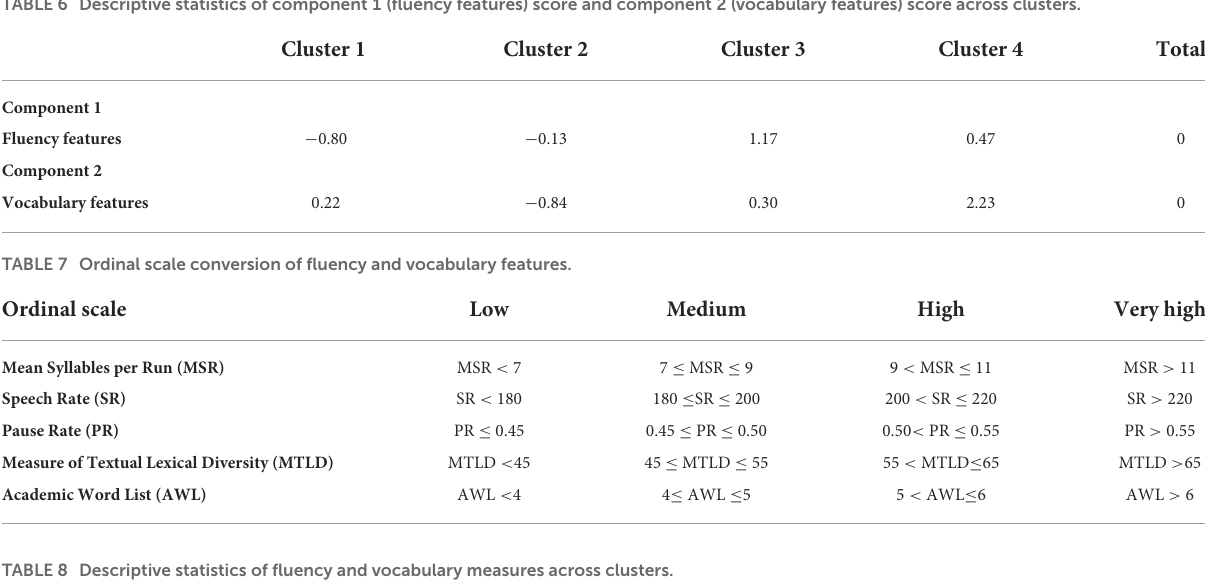
TABLE 6 Descriptive statistics of component 1 (fluency features) score and component 2 (vocabulary features) score across clusters.